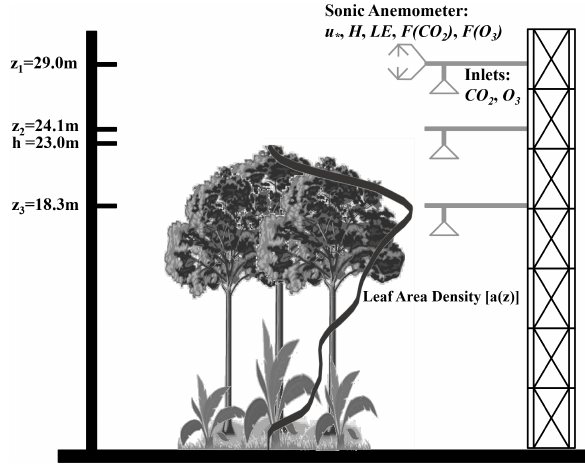
Figure 1. Schematic of flux and concentration gradient measure- ments at Harvard Forest Environmental Measurement